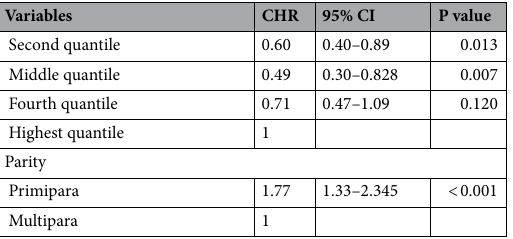
Table 6. Bivariate cox proportional hazards model of cessation of EBF among women who have 6–12 months’ age child in Debretabor town, North West Ethiopia, 2019.